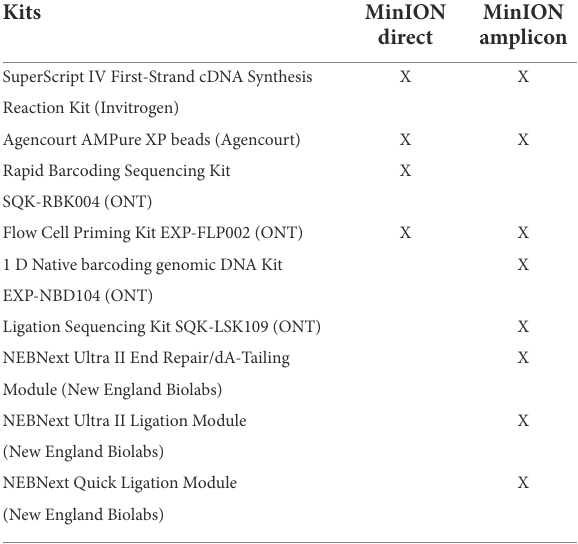
TABLE 2 List of kits needed for direct DNA sequencing (MinION direct) and amplicon sequencing (MinION